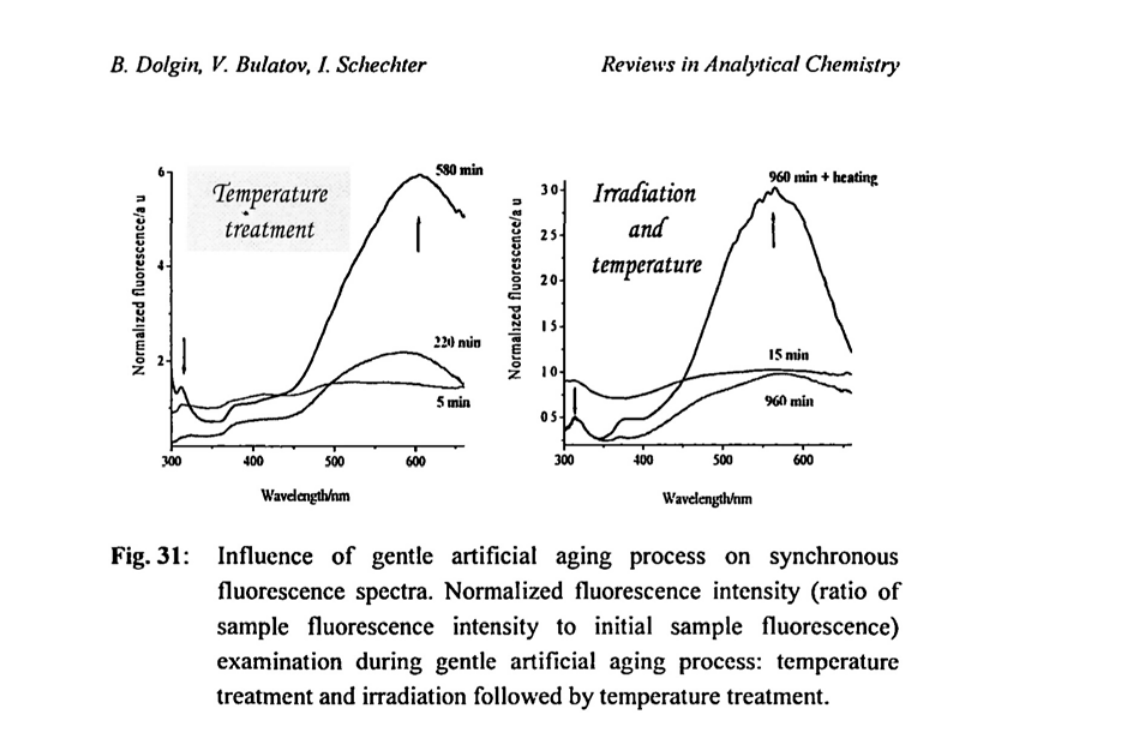
Fig. 31: Influence of gentle artificial aging process on synchronous fluorescence spectra. Normalized fluorescence intensity (ratio of sample fluorescence intensity to initial sample fluorescence) examination during gentle artificial aging process: temperature treatment and irradiation followed by temperature